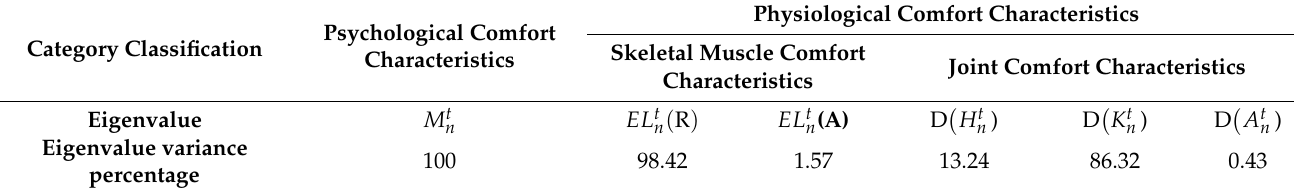
Table 7. Classification of comfort features and results of principal component